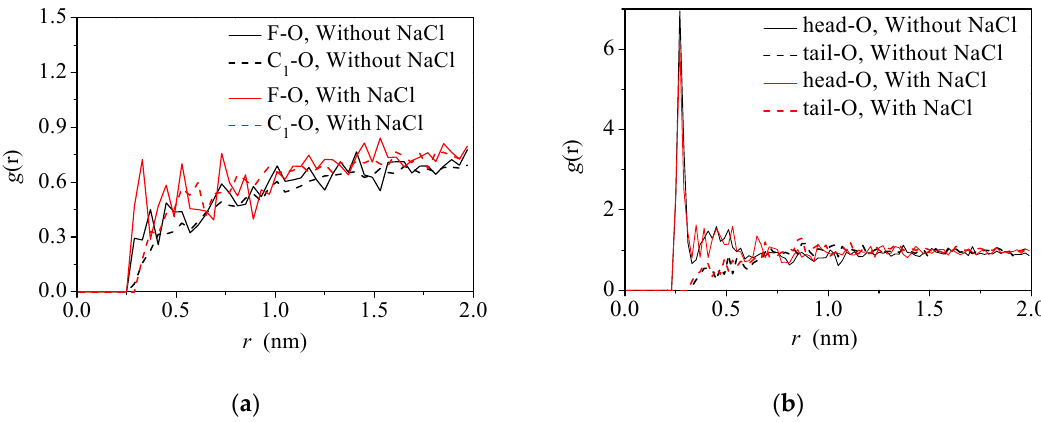
Figure 10. The radial distribution functions g (r) of hydrophilic and hydrophobic parts of organic solvents and water molecules at different oil–water interfaces: ( a ) The g ( r ) of C 1 -O and F-O in the fluorobenzene–water system; ( b ) The g ( r ) of head-O and tail-O in 1-the pentanol–water system.